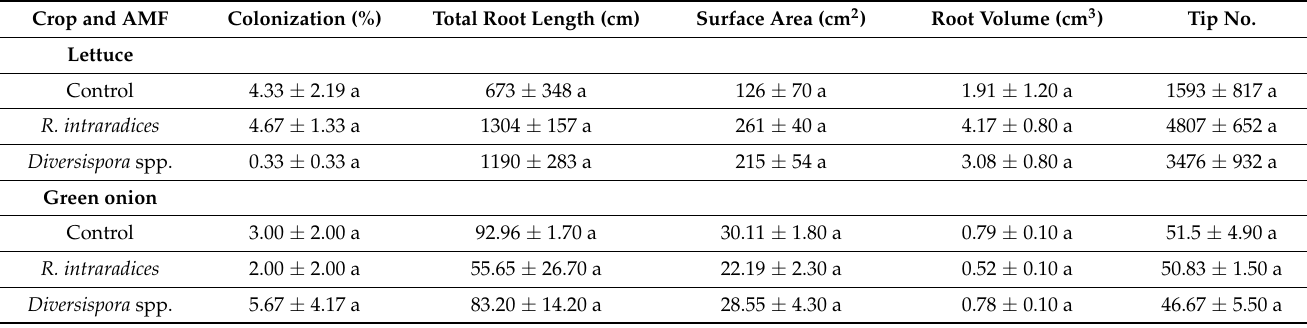
Table 1. Mycorrhizal colonization and root system parameters of lettuce and green onion on the day of harvest after application of two AMF ( R. intraradices or Diversispora spp.) or without (control). Different letters within row (average values ± SE) indicate significant differences ( p <